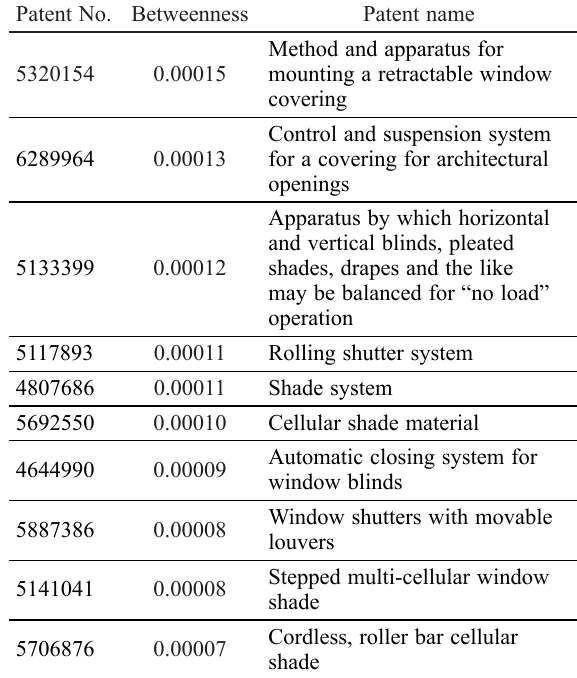
Table 5. Betweenness centrality of the top 10 patents in the technology field Patent No.